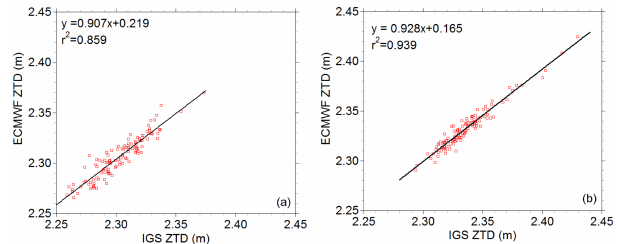
Figure 3. Scattergram of ECMWF and IGS ZTDs at stations KIRU (a) and NNOR (b) . The vertical and horizontal axes show ECMWF and IGS ZTDs (m), respectively. The correlation coeffi- cients ( r ) and the results of a linear regression are also displayed.